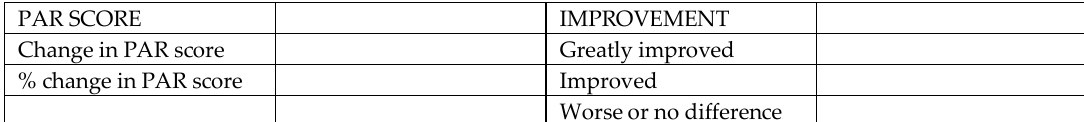
Figure 8. Form used to perform Peer Assessment Rating (PAR) score.